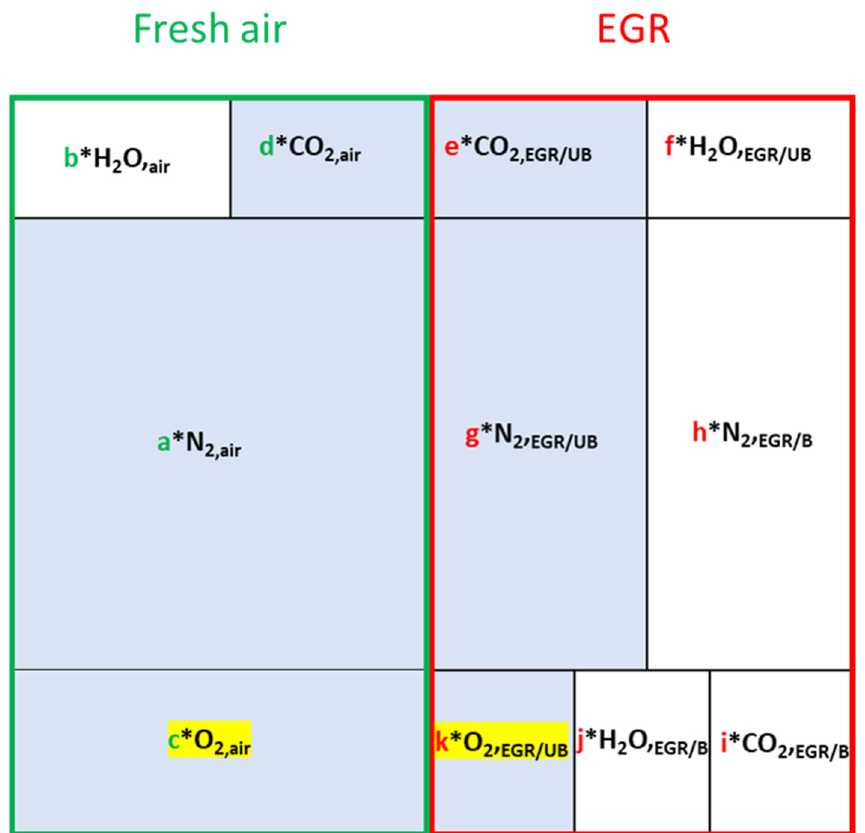
Figure 5. Graphical representation of the composition of the charge introduced into the combustion chamber.